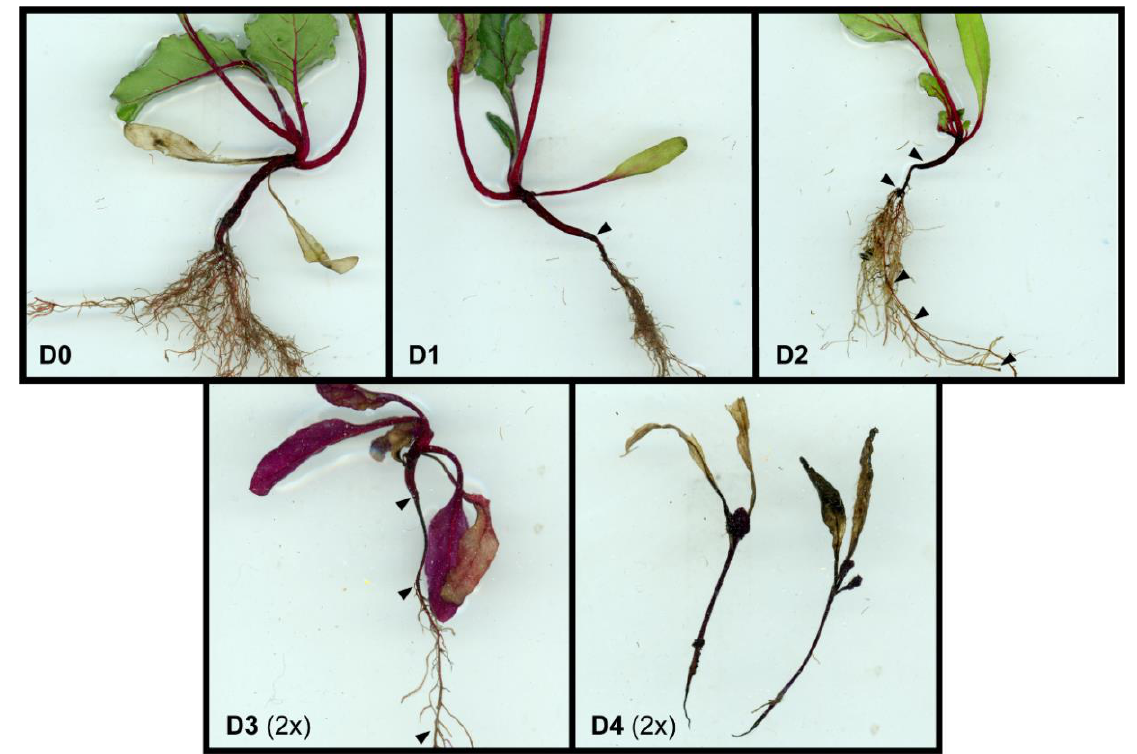
Figure 1. Classification of disease severity of beetroot seedlings based on lesions. Arrows indicate areas with dark lesions and thinning of the crown, stem, and root. Photos for D3 and D4 are shown at 2× magnification as compared to D0, D1, and D2. R. solani isolates were obtained from plants that had lesions, and they were identified as such by Sanger sequencing (data not shown). Photographs taken by the authors.